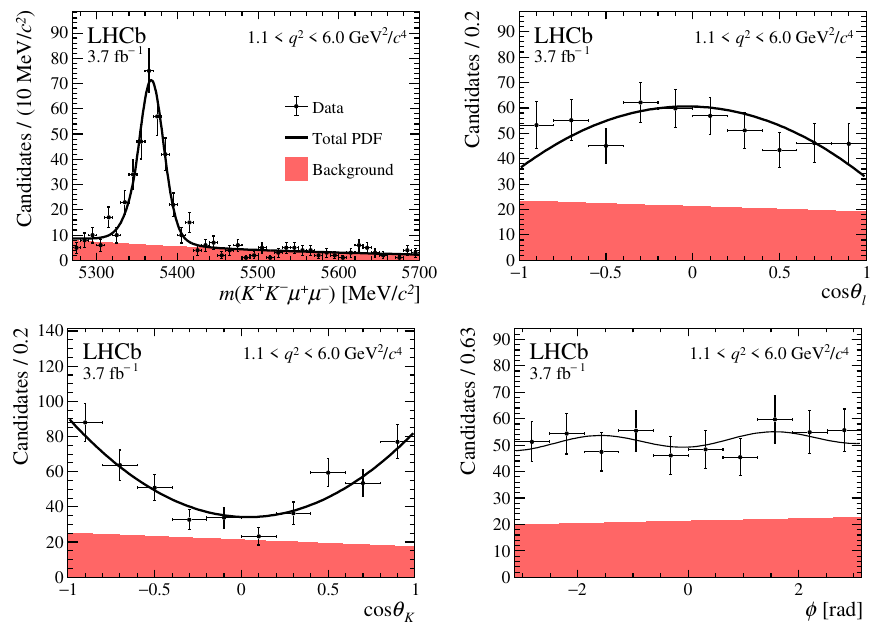
Figure 29 . Mass and angular distributions of B 0 1 . 1 < q 2 < 6 . 0 GeV 2 /c 4 for data taken in 2017–2018. The data are overlaid with the projections of the fitted